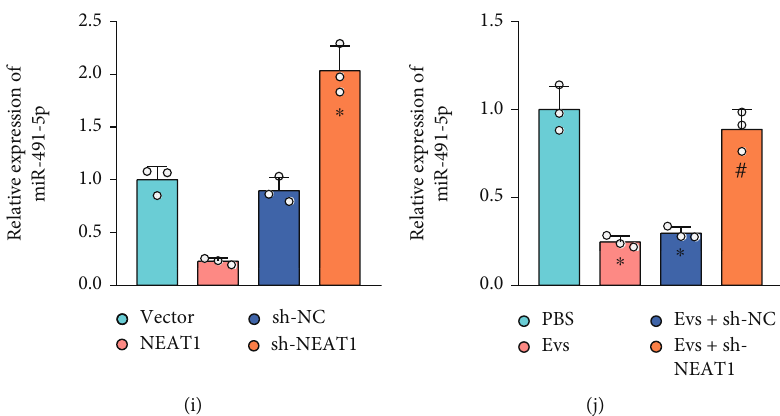
Figure 4: Veri fi cation of the binding between NEAT1 and miR-491-5p in PCa cells. (a) The binding site between NEAT1 and miR-491-5p in PCa cells predicted by the StarBase database. (b) The colocalization of NEAT1 and miR-491-5p detected by FISH (scale bar: 25 μ m). (c) The relationship between miR-491-5p expression and the prognosis of PCa patients (44 patients with high miR-491-5p expression and 132 patients with low miR-491-5p expression) analyzed by Ualcan database. (d) miR-491-5p expression in dasatinib-sensitive PCa cell lines and dasatinib-resistant PCa cell lines analyzed in GSE59357 ( n = 3 ). (e) Luciferase activity of NEAT1-WT/MUT analyzed by dual-luciferase reporter gene assay. (f) Enrichment of miR-491-5p by NEAT1 in SW1990 cells treated with anti-Ago2 or anti-IgG detected by RIP. (g) RNA pull-down assay for a biotinylated NEAT1 and an NC probe, miR-491-5p enrichment detected by RT-qPCR. (h) NEAT1 expression in SW1990 cells treated with overexpression vector or shRNA-mediated NEAT1 measured by RT-qPCR. (i) miR-491-5p expression in SW1990 cells treated with overexpression vector or shRNA-mediated NEAT1 measured by RT-qPCR. (j) miR-491-5p expression in SW1990 cells cocultured with EVs from sh-NEAT1-treated ADSCs measured by RT-qPCR. ∗ p < 0 : 05 vs. SW1990 cells transduced with mimic NC or inhibitor NC, SW1990 cells treated with Bio-NC-probe, Vector, or PBS; # p < 0 : 05 vs. SW1990 cells transduced with sh-NC or SW1990 cells cocultured with EVs from ADSCs transduced with sh-NC. All data were presented as mean ± standard deviation. Comparisons of data between two groups were analyzed by unpaired t -test, and comparison of data among multiple groups was tested by one-way analysis of variance, followed by Tukey ’ s post hoc test. Cell experiments were independently repeated three